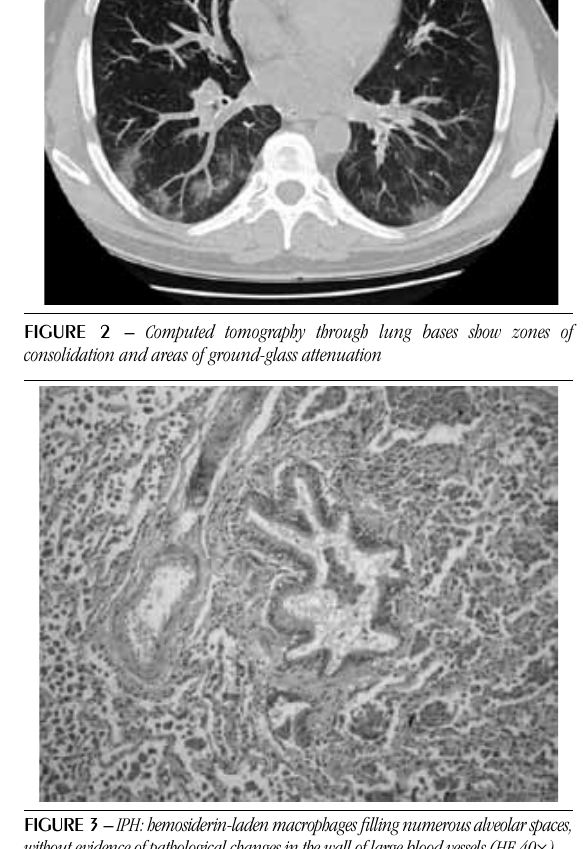
figurE 6 – Granules of hemosiderin can be highlighted on Prussian blue stains (100×)